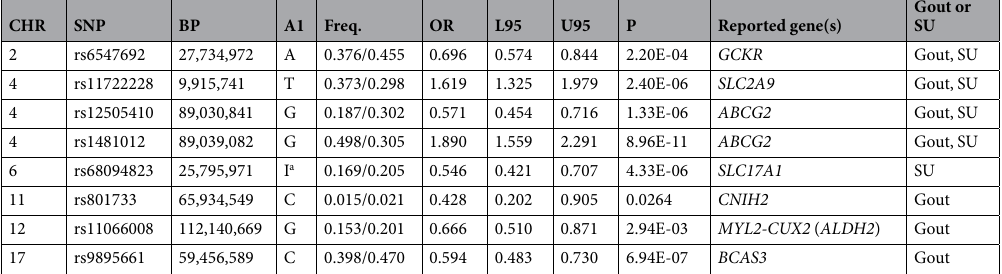
Table 1. Replication of previously reported gout/SU GWAS associations in a cohort of Han Chinese. a I, insert; CHR, Chromosome; SNP, dbSNP rs number; BP, Position, based on hg19; A1, minor allele for the whole sample; Freq., frequency of A1 for cases/controls; OR, odds ratio, for A1; L95, the lower endpoint of the 95% confidence interval (CI); U95, the upper endpoint of the 95% confidence interval; P, p value. Reported gene(s), The reported gene(s) in the previous GWAS; Gout or SU, indicating whether the locus found to be associated with gout or SU. All the OR (95% CI) and p values reported in this study were based on the PCA adjustment analysis.